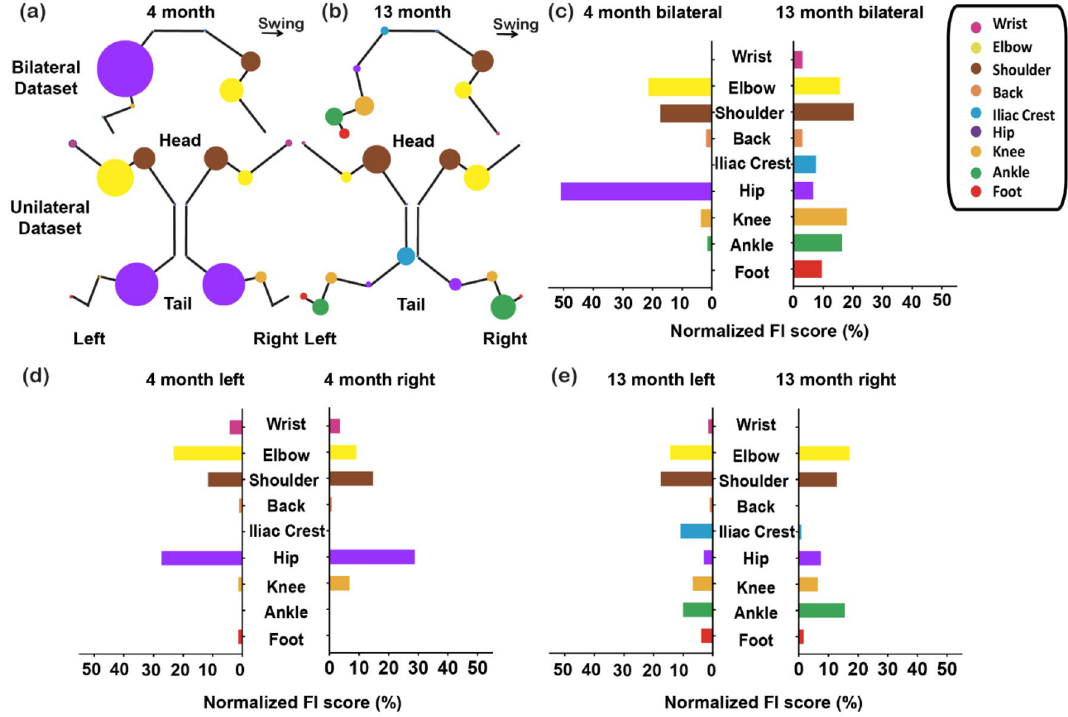
Figure 5. Feature scores for each anatomical location in different datasets. Four-month-only and 13mon-only datasets yielded different cumulative FI scores (%) for different anatomical locations, suggesting that kinematic synergy (or the lack thereof) during locomotion was correlated with age and pathological progression. Each bubble shown represents an anatomical location analyzed in this study. The size of the bubble is proportionate to its cumulative FI score calculated from bilateral or unilateral datasets of ( a ) the 4mon-only group, and ( b ) the 13mon-only group. The cumulative FI scores (%) were calculated by summing all the FI scores related to each anatomical location. All 82 features extracted from all body parts were included. As the mice aged, more joints become important for differentiating the two genotypes instead of just the hip, shoulder, and elbow ( c ). The left–right comparison was also performed for 4mon ( d ) and 13mon ( e ) respectively. Panels generated through MATLAB 9.2 and Adobe Illustrator